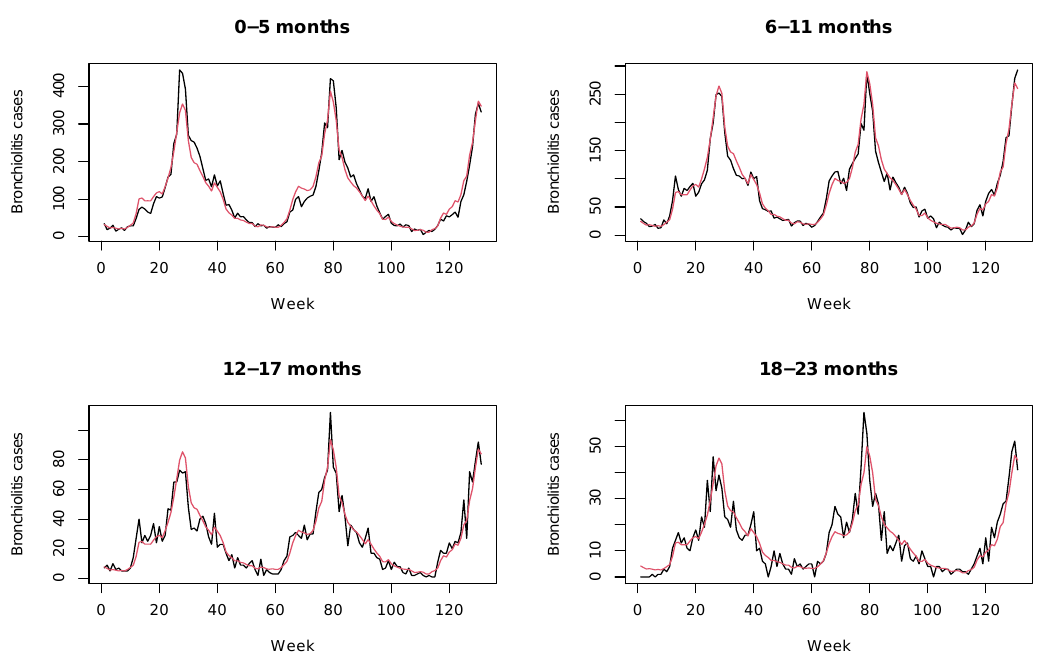
Figure 2. Model accuracy. Bronchiolitis counts (black line) together with posterior mean estimates (red line) from July 2010 to December 2012 (T = 131 weeks) obtained with the proposed model based on the negative binomial